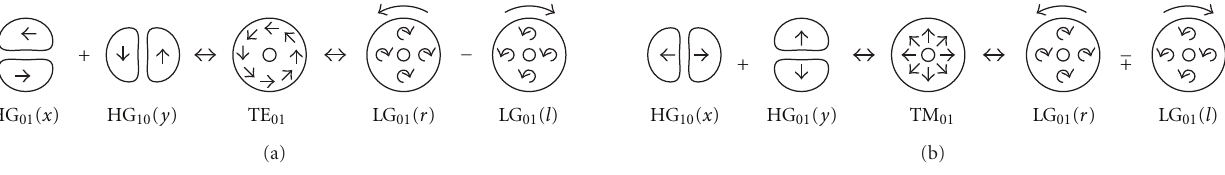
magnetic field in the direction of propagation (TM 01